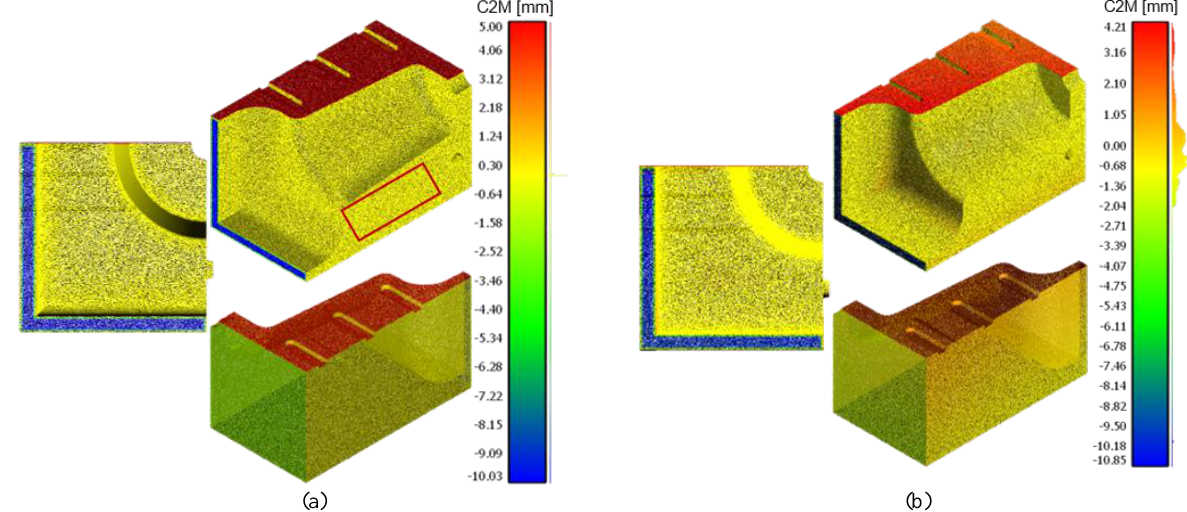
Figure 4 . Deviation distance analysis of the simulated data using C2M. (a): GT-Pose, and (b): ICP.